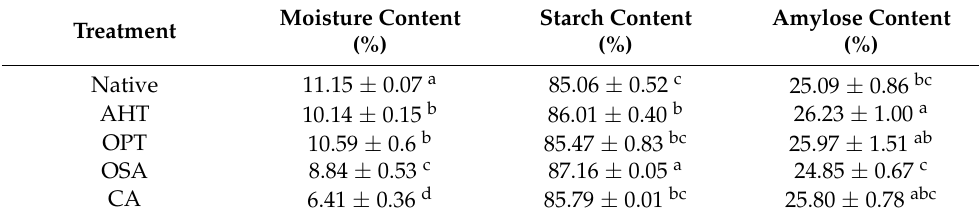
Table 1. Chemical composition of native and various modified sago starches.